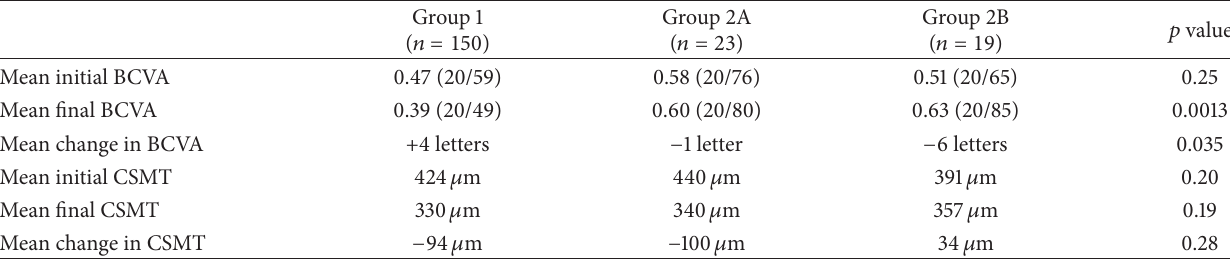
Table 3: Subgroup analysis: outcomes in eyes that received early IVT-TA (group 2B) and eyes that received IVT-TA due to DME refractory to anti-VEGF treatment (group 2A).